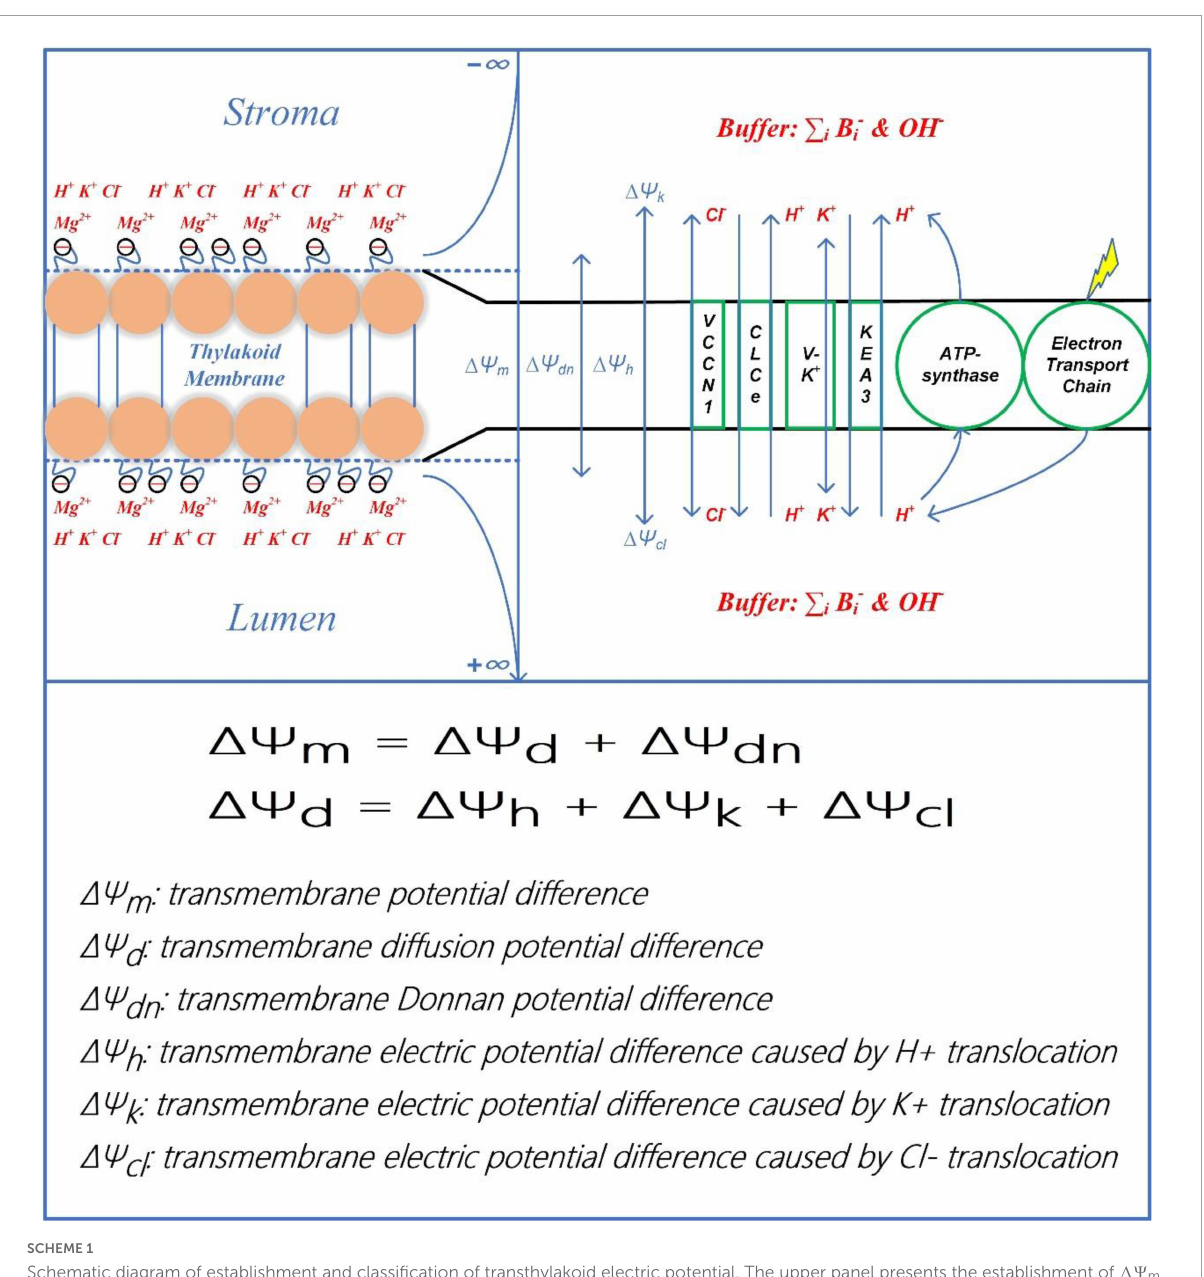
SCHEME1 Schematic diagram of establishment and classification of transthylakoid electric potential. The upper panel presents the establishment of (cid:49)(cid:57) m and its components. The onset of electron transport as illumination commences is coupled to the proton translocation from the stroma into the lumen. The proton motive force is thus established due to the acidification of the lumen and the alkalization of the stroma, which is ultimately used to drive the ATP synthesis through the CF 0 –CF 1 type of ATP-synthase in chloroplasts. In response to the environmental conditions, the proton motive force is partitioned into its two components ( (cid:49) pH and (cid:49)(cid:57) m ) via ion channels/antiporters, i.e., the voltage-gated K + channel V–K + , the K + /H + antiporter KEA3, the voltage-gated Cl − channel VCCN1, and the Cl − channel CLCe. The resultant effect of ion redistribution causes the formation of the diffusion potential difference ( (cid:49)(cid:57) d ) which includes three components, i.e., (cid:49)(cid:57) h , (cid:49)(cid:57) k , and (cid:49)(cid:57) cl . It can be observed that both surfaces of the thylakoid membrane carry fixed negative charges whilst the negative charge density on the luminal side is more significant than the stromal side. To equilibrate the initial transthylakoid Donnan potential in darkness, the fixed negative charge on either membrane-surface is equally assigned the value of − 0.035 C m − 2 . Besides, Donnan potential difference ( (cid:49)(cid:57) dn ) is established between the membrane-surface and the electrolyte solution. The electrostatic (cid:49)(cid:57) dn is often sufficiently negative to attract mobile divalent cations (e.g., Mg 2 + ) more than mobile monovalent cations (e.g., K + , H + ) and repel mobile anions (e.g., Cl − , OH − ). The enriched cations (Mg 2 + , K + , and H + ) can also bind to negative charge sites and/or neutral sites, ultimately altering the membrane-surface negativity. In the lower panel, the calculating equation for (cid:49)(cid:57) m and the definition for all components of (cid:49)(cid:57) m are